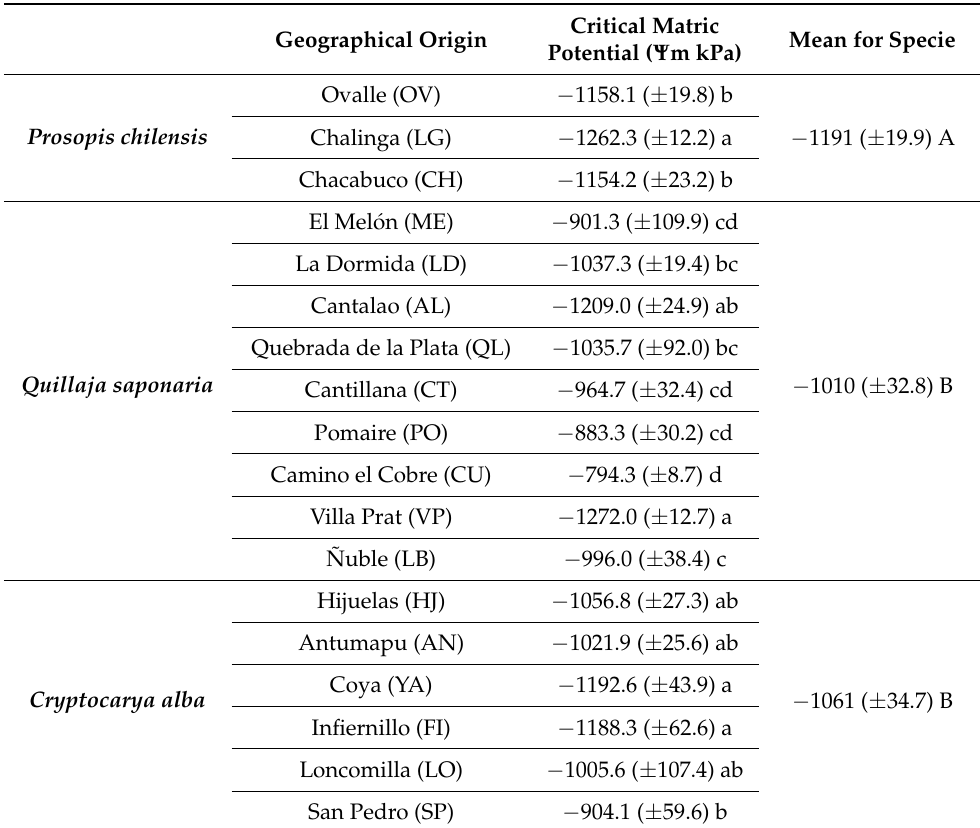
Table 4. Critical matric potential for per seed source at species level. Lowercase letters indicate statistically significant differences within geographic origins for critical matric potential (kPa) when germinative capacity is 0%. And capital letters statistically significant differences between species. According to the LSD-Fischer multiple comparison test ( p <